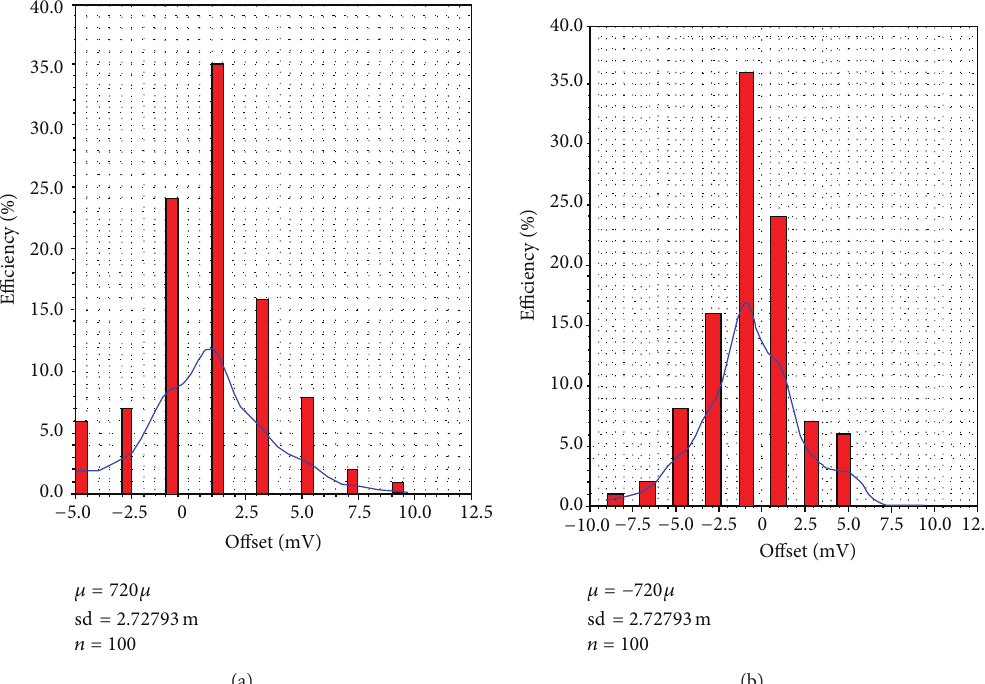
Figure 6: Postlayout Monte-Carlo simulation result with process and mismatch